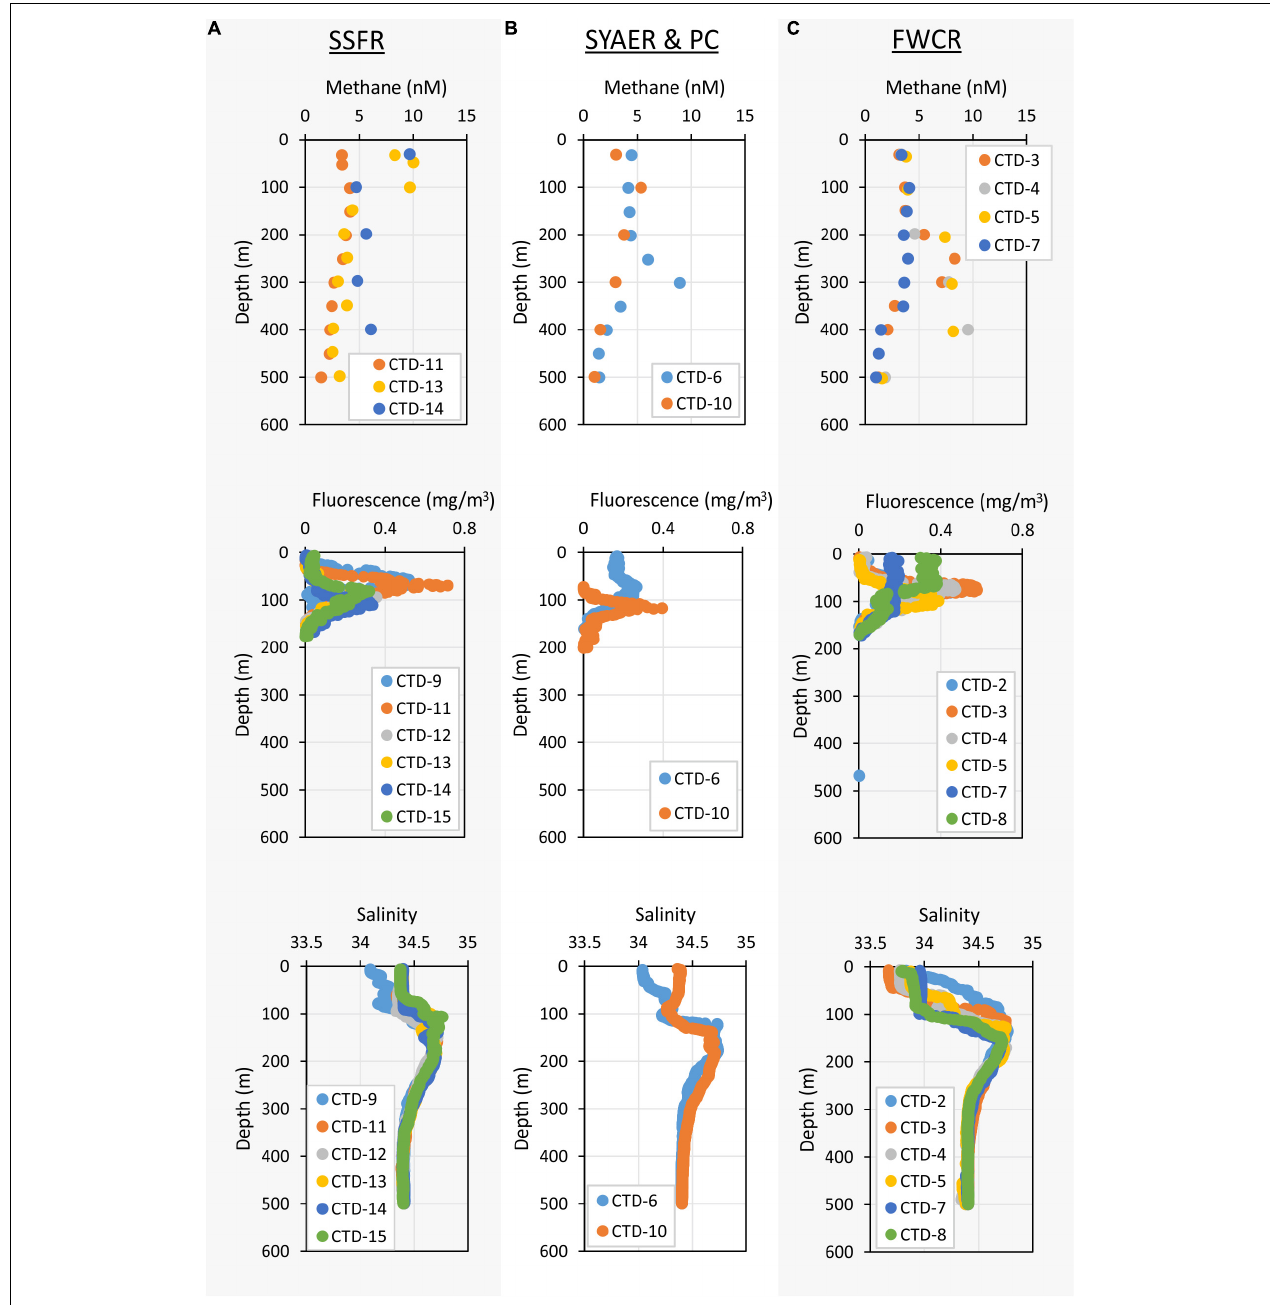
FIGURE 3 | Depth profiles of methane concentrations – upper row, fluorescence – middle row, and salinity – lower row of the uppermost 500 m. (A) Shows the measurements of stations at SSFR – Southern Summit Formosa Ridge, (B) displays station data of SYAER – South Yun An East Ridge (CTD-6) and PC – Penghu Canyon (CTD-10), and (C) shows data recorded above FWCR – Four Way Closure